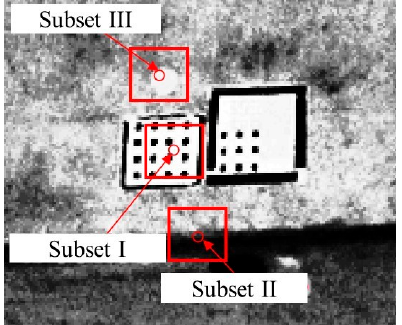
Figure 23. Example of differences in contrast at the measurement subset position (bridge B).